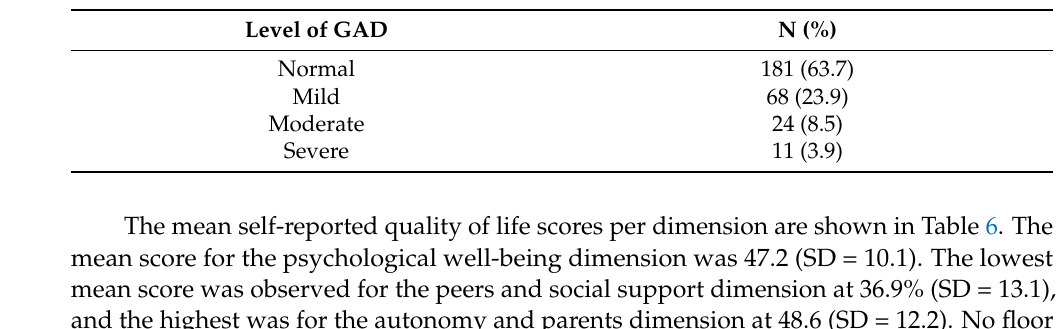
Table 5. Levels of Generalized Anxiety Disorder in the sample population (N = 284).